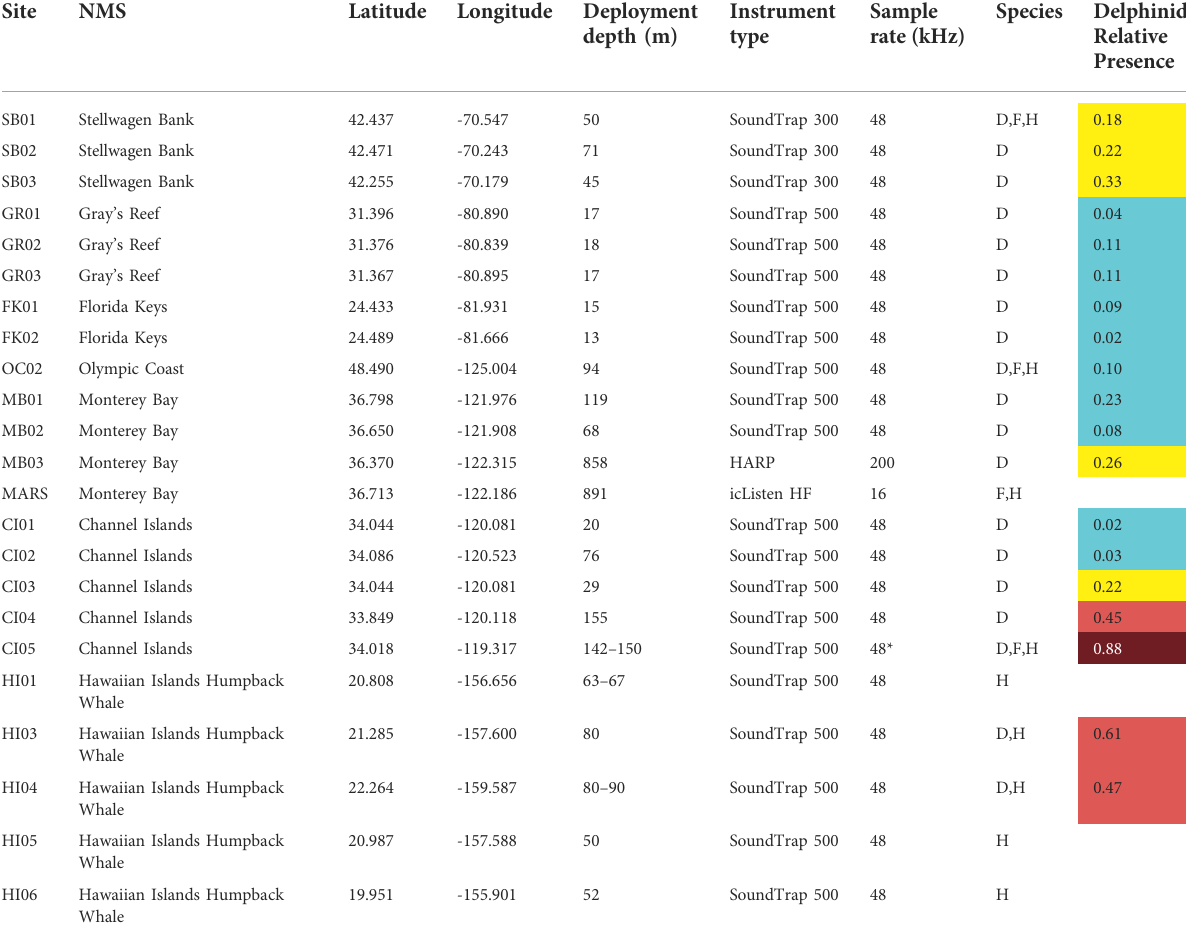
TABLE 1 Site name (Site) and the corresponding sanctuary (Sanctuary) for each instrument used in the study, along with the recording locations (LatitudeandLongitude),depthoftherecorderatthatsite(Deploymentdepth),theinstrumenttype(Instrumenttype),samplerate(Samplerate), and what species were analyzed at that site (Species; D = delphinid, F = fi n whale, H = humpback whale). All baleen whale analyses occurred from 1 November 2018 to 31 October 2020, and all delphinid analyses occurred from 1 June 2019 to 31 May 2020. If the site was used for delphinid analyses,the total hours presentat a given site normalized by recordingeffort(DelphinidRelativePresence) is presented as a ratio from 0 – 1,and hasbeencolorcodedbasedon “ low ” (blue), “ medium ” (yellow), “ high ” (red),and “ veryhigh ” (darkred)categories.Sitesthatwerenotanalyzedfor delphinids are left as blank. NMS = National Marine Sanctuary. *Denotes that data collected from 1 November 2018 to 4 February 2019 were collected at a 96 kHz sampling